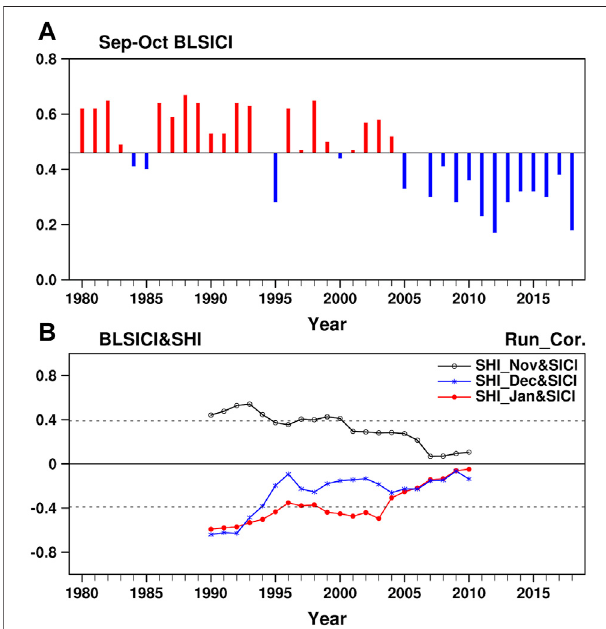
FIGURE 10 | (A) Time-series of BLSICI in September – October [area- averaged (75 ° – 85 ° N, 30 ° – 140 ° E) Arctic sea-ice concentration] during 1980/ 81 – 2018/19. (B) The 19-years sliding correlation coef fi cients between September – OctoberBLSICIandtheSHIinNovember(blackline),December (blue line) and January (red line) separately, during during 1980/81 – 2018/19. Dotted lines denote correlations above the 90% con fi dence level.